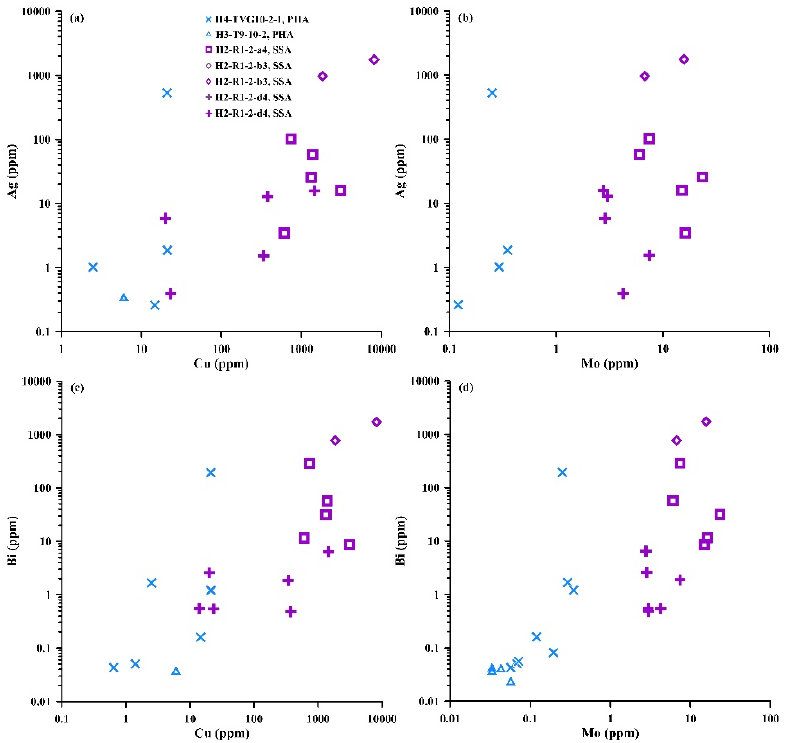
Figure 14. Plots of anglesite from MOT (samples H2-R1-2-a4, b3, d4) and SOT (samples H3-T9-10-2, H4-TVG10-2-1) hydrothermal fields: ( a ) Ag vs. Cu; ( b ) Ag vs. Mo; ( c ) Bi vs. Cu; ( d ) Bi vs. Mo. PHA—primary hydrothermal anglesite; SSA—secondary supergene anglesite.